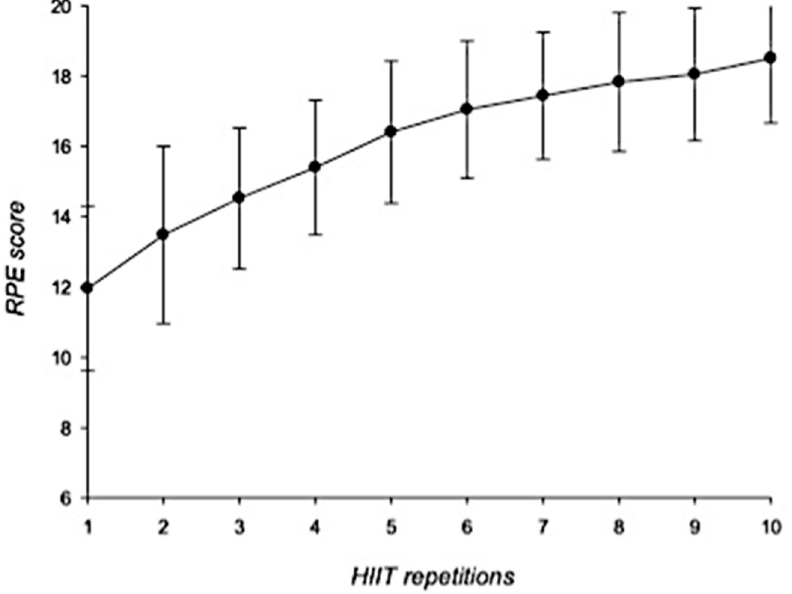
Figure 2. RPE scores during HIIT intervention. Error bars represent standard deviations. RPE = rates of perceived exertion; HIIT = high-intensity interval training. n = 25.